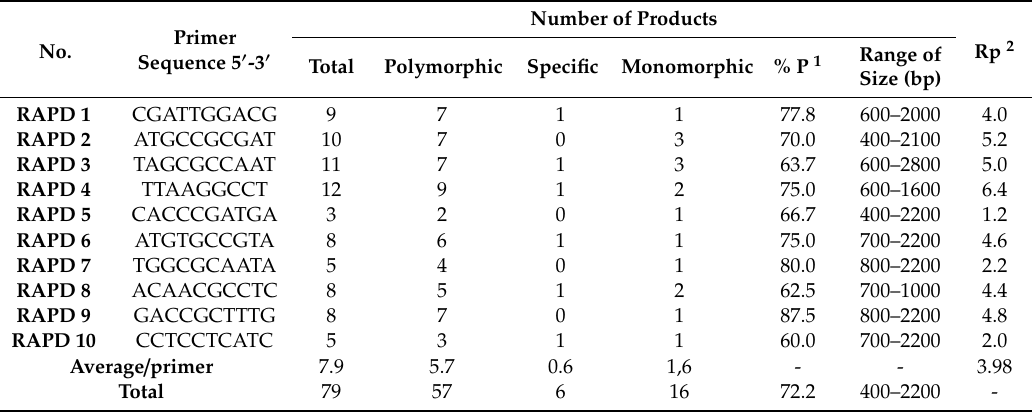
Table 3. Primer sequence, number of products and other parameters for each RAPD